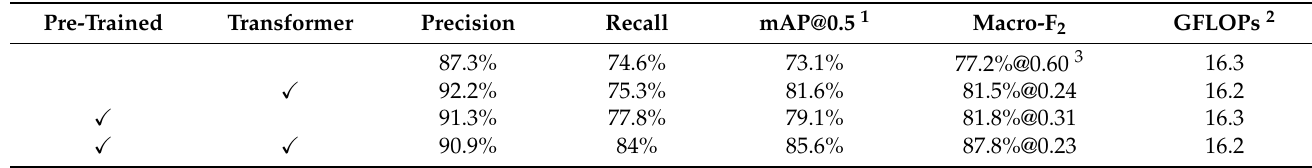
Table 4. Influence of pre-trained weighting and transformer module on the YOLOv5s recognition performance, including precision, recall, mAP, macro-F2 and